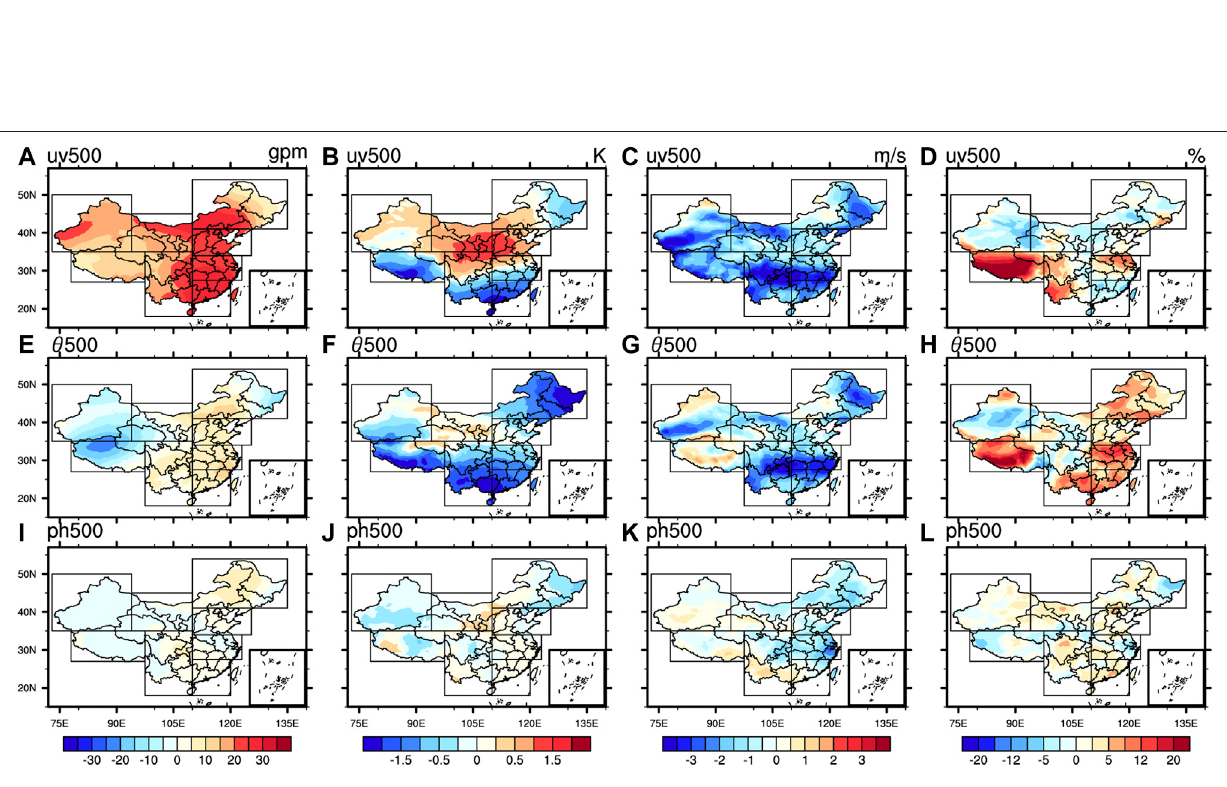
Frontiers in Earth Science |